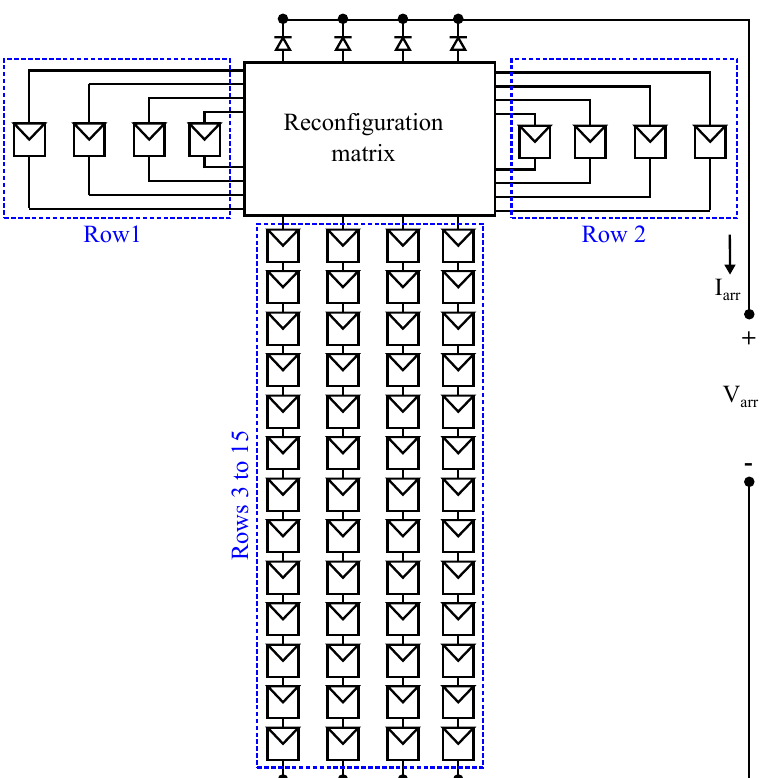
Figure 7. Reconfiguration system used in the application